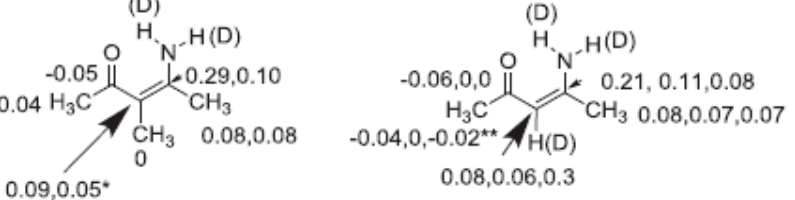
Figure 9. Deuterim isotope effects on 13C chemical shifts. * The central line is broad, so no isotope effect could be measured. ** Assignment tentative. Reprinted with permission from Ref. [29]. Copyright 2019 Elsevier.